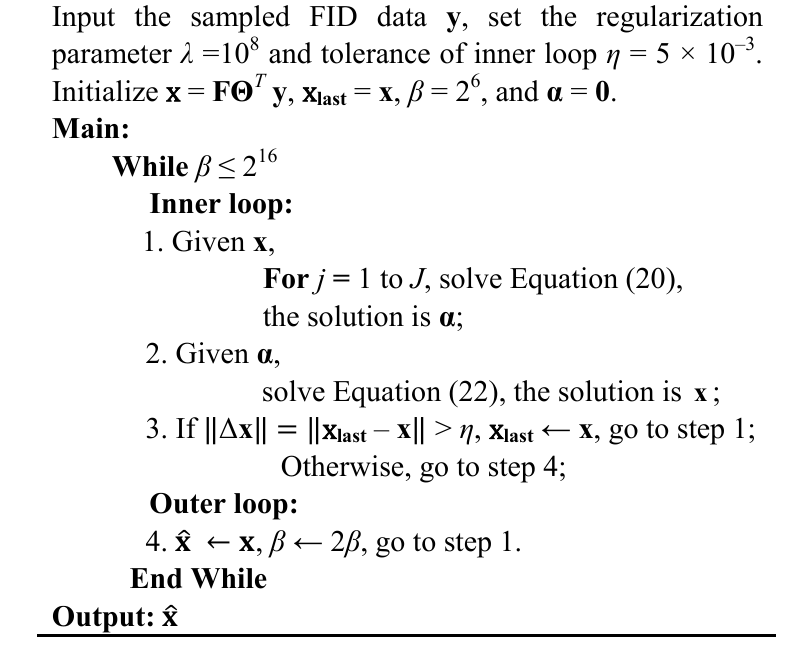
Algorithm 1. Self-sparse NMR spectra reconstruction with undersampled data using